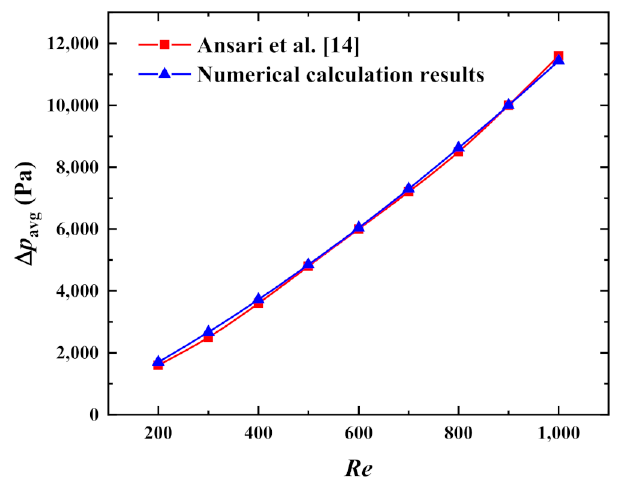
Figure 6. Verification of model validity in the maximum pressure drop versus Re .